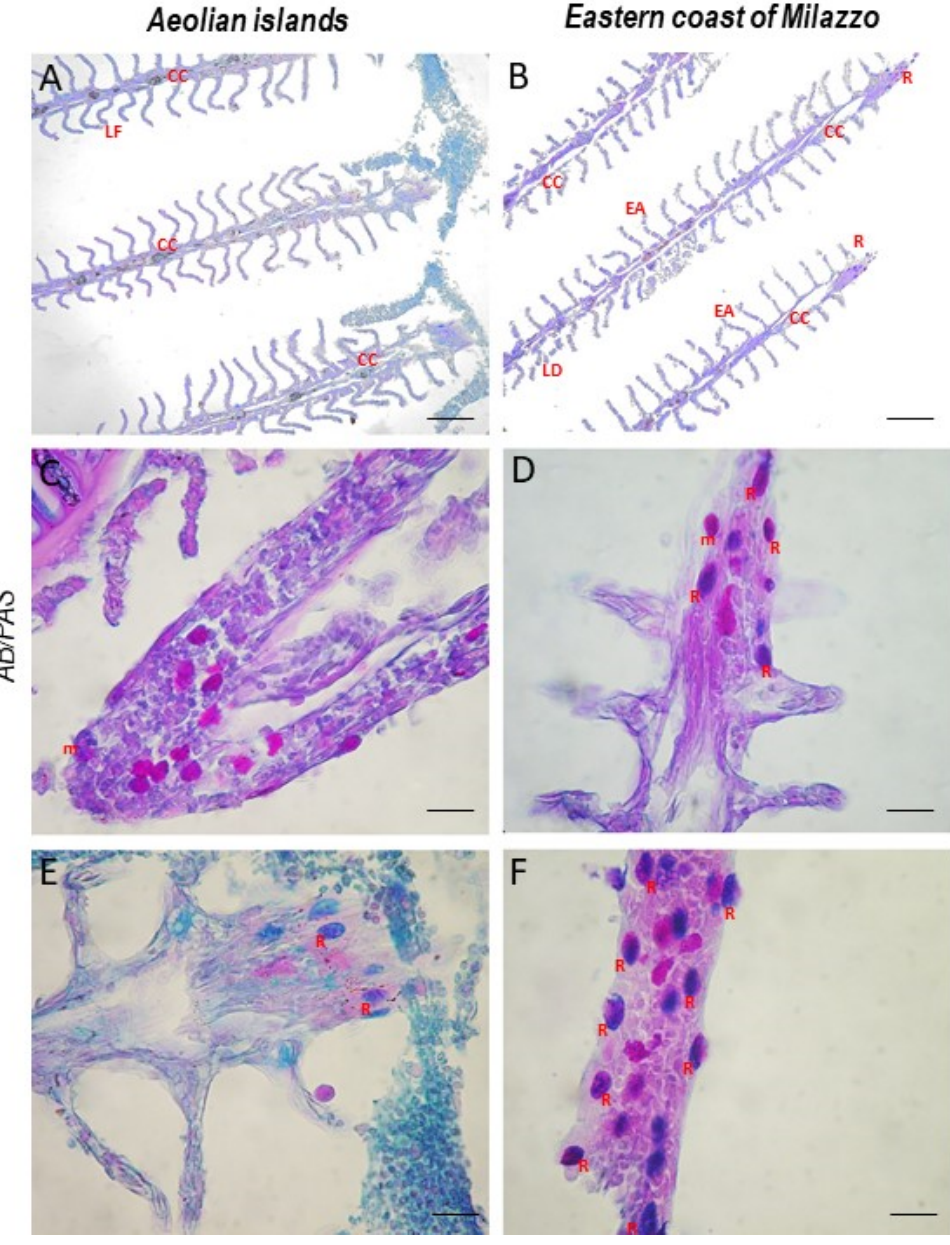
Figure 2. Boops boops gill section stained with AB/PAS. ( A , B ) 20×, scale bar 20 μ m. ( C – F ) 100×, scale bar 100 μ m. The gills of both groups have a slightly altered morphology, with mucous cells at the apex of the filament. In fish from the eastern coast of Milazzo, is possible to note a cartilaginous core, lamellar damage, and epithelial alterations, occasionally resulting in lamella fusion. An increase in RCs was evident in fish more exposed to heavy metals. CC = cartilaginous core; LD = lamellar damage; EA = epithelial alterations; LF = lamellar fusion; R = rodlet cells; m = mucous cells. An increase in RCs was evident in fish from the eastern coast of Milazzo. AB/PAS staining revealed RCs in different states of differentiation in the gills of Boops boops (Figure 2). S100-positive RCs were characterized by immunoperoxidase (Figure 3).